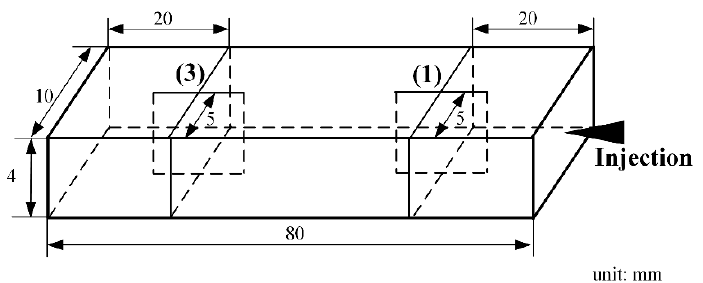
Figure 9. Details of sections on the part for the droplet morphology experiment.